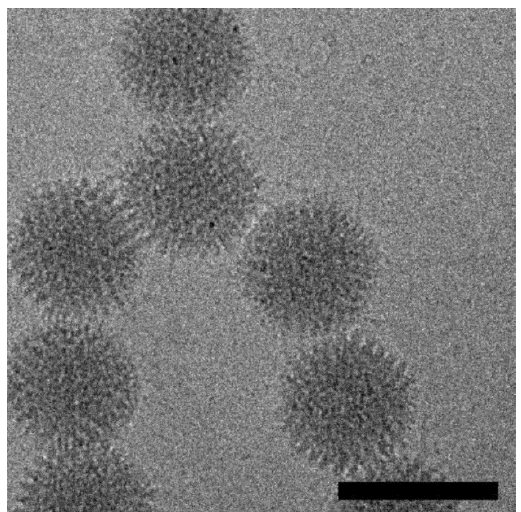
Figure 1. A digital cryo-electron micrograph of the Adenovirus serotype 5 (Ad-5) / HVR5-33RGD vector. Adenoviruses are non-enveloped, double-stranded DNA viruses that cause cold-like infections of the upper respiratory tract. These viruses have an icosahedral-shaped capsid that ranges from 90–100 nm in diameter and a ~36-kb genome. This image was collected on a Tecnai-12 microscope using a Gatan UltraScan 1000 (2k × 2k) CCD camera. The scale bar represents 1,000 Å. Image provided courtesy of Dr. Phoebe Stewart, Case Western Reserve University, Cleveland, OH, USA.